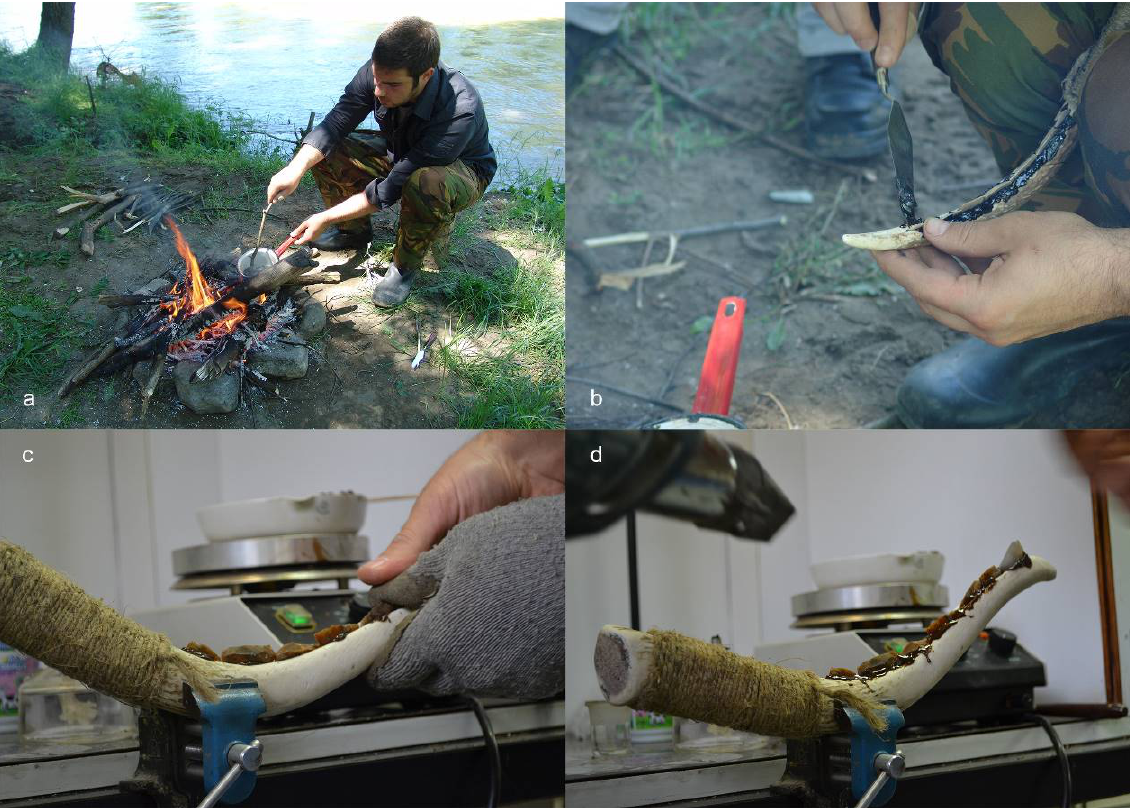
Figure 6. a, b: inserting in the open fire condition; c, d: inserting in controlled laboratory